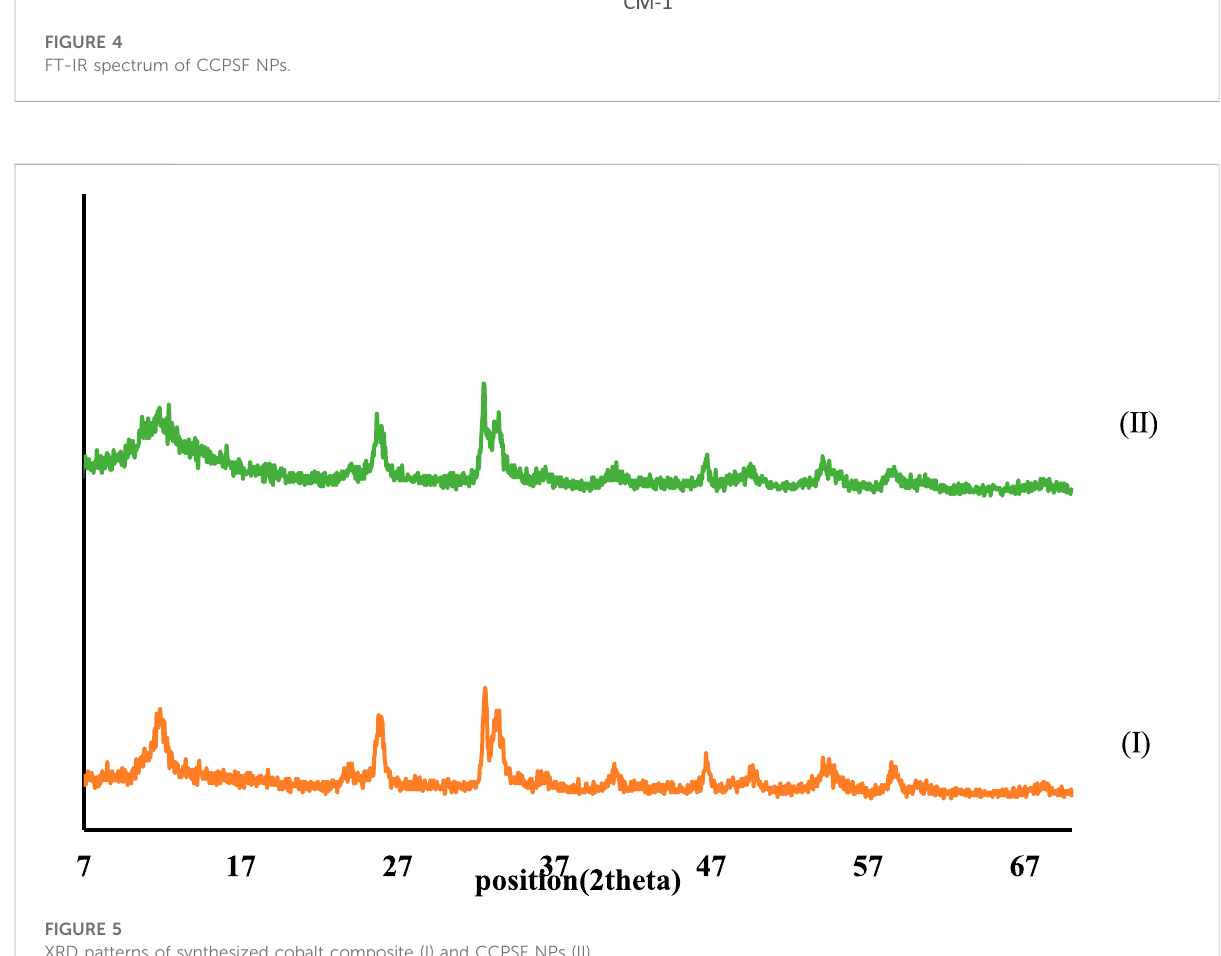
FIGURE 4 FT-IR spectrum of CCPSF NPs.